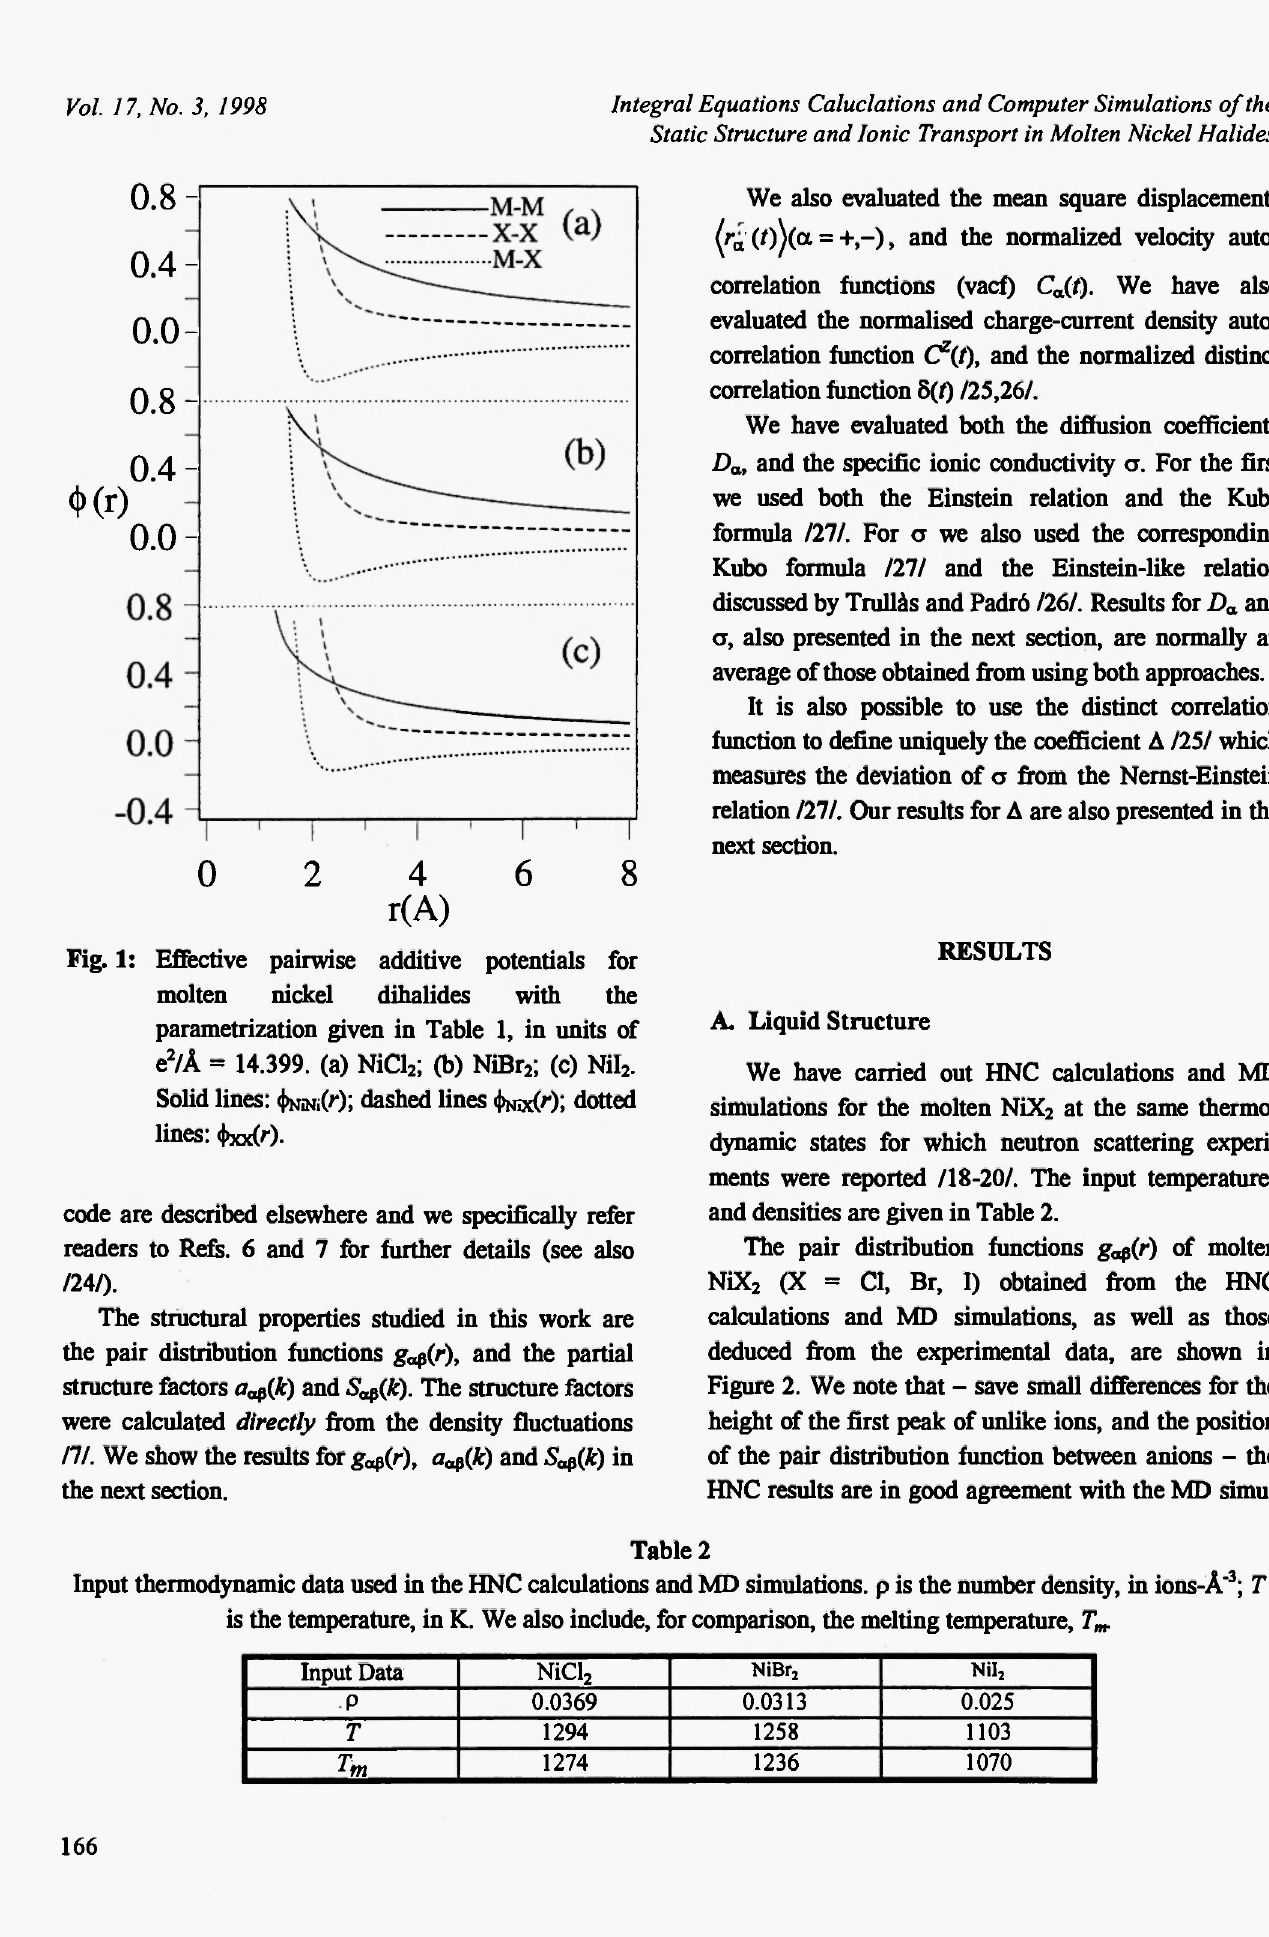
; (b) NiBr ; (c) Nil . 2 2 2